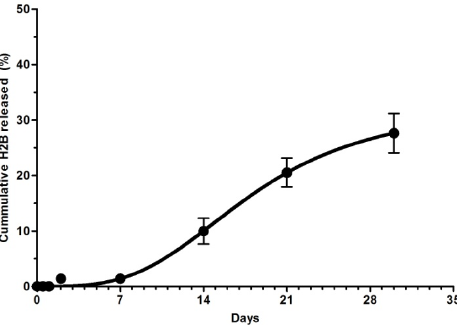
Figure 4. Release of adsorbed H2B peptide over time. A known amount of H2B/PLA was suspended in PBS buffer solution (pH~7.4) (GIBCO) at 37 °C. Protein desorption was followed at predetermined time intervals. Supernatants were collected at each point, and protein concentration was determined using a micro BCA assay kit (St. Louis, MO, United State, Sigma-Aldrich). Desorption rate was expressed as the cumulative percentage.